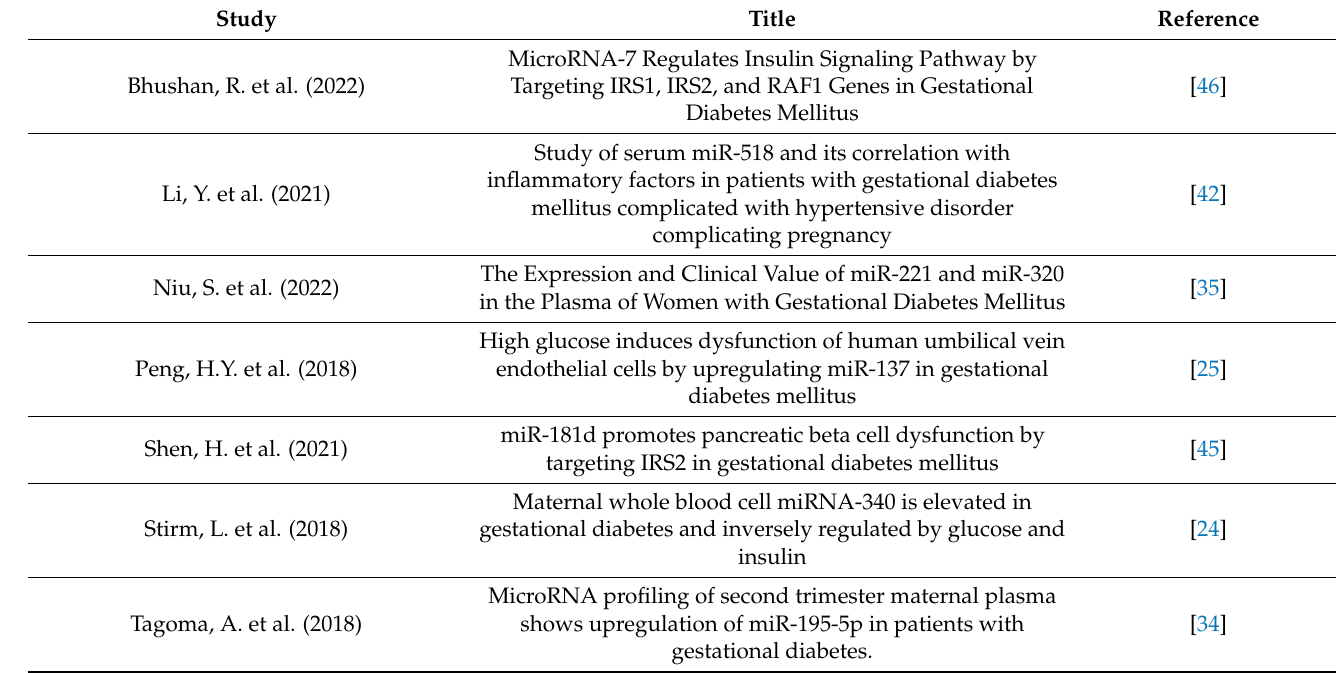
Table 2. Studies included only in the qualitative systematic